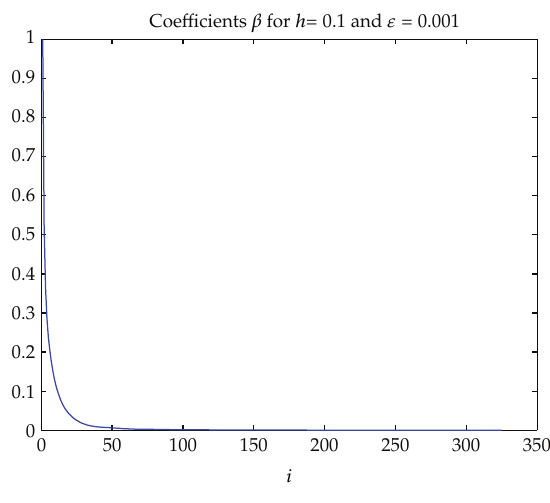
Figure 4: Coe ffi cients β for ε (cid:8) 0 .